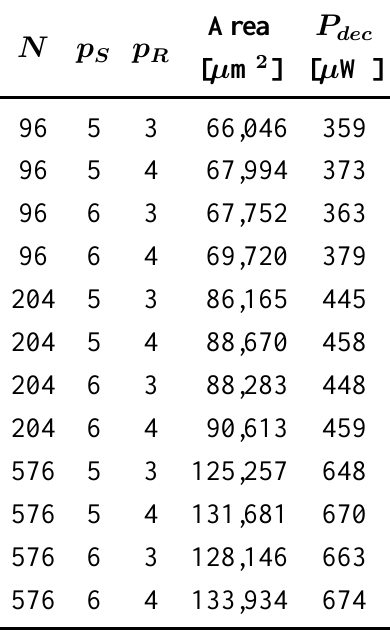
Table 1. Post place and route area and power consumption of the proposed